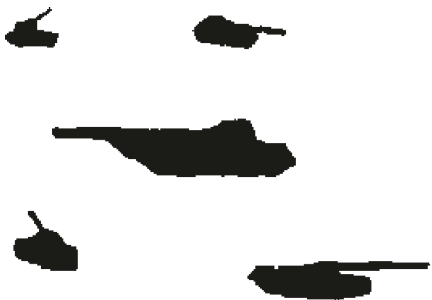
Figure 4: Shape prior database of tank